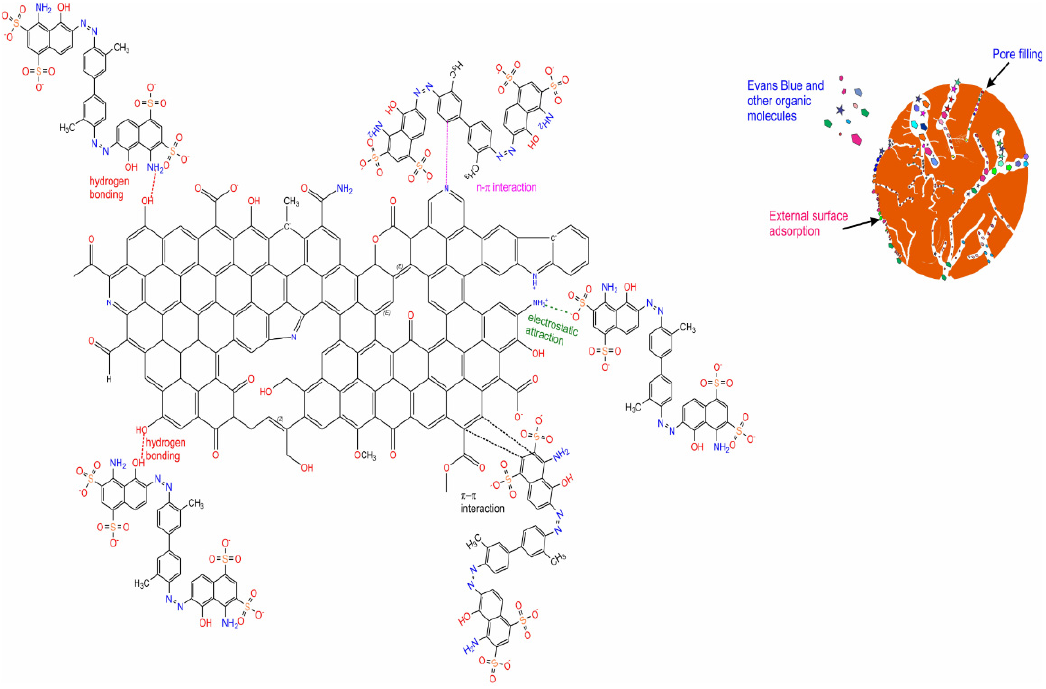
Figure 13. Proposed mechanism of adsorption.